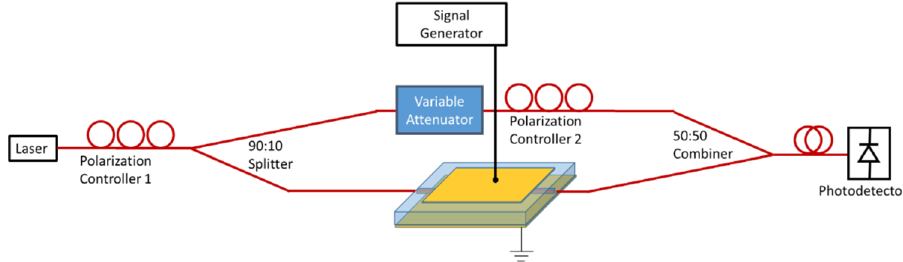
Figure 4. The testing setup to measure the r 33 of a poled polymer waveguide.